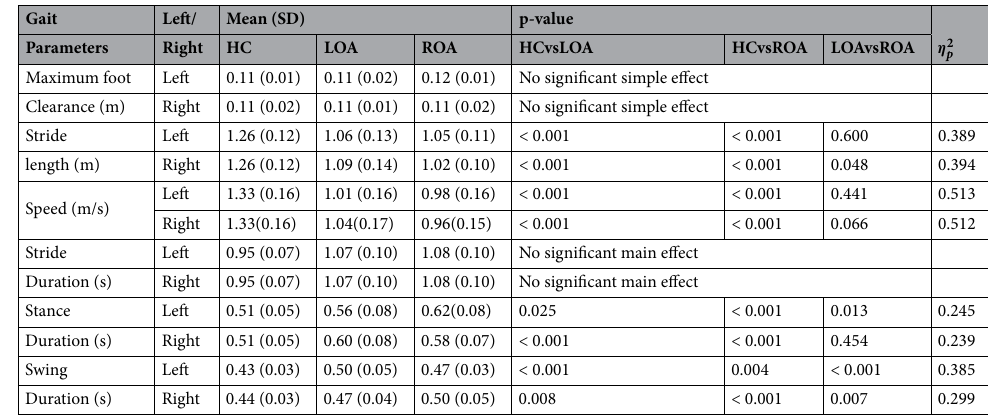
Table 2. The result of multiple comparison tests for the group. For the gait parameters other than the maximum foot clearance and the stride duration, the significant interactions and simple effect of group were found. Thus, the multiple comparison was conducted for the groups for the left and right legs separately. In the maximum foot clearance, a significant interaction was found but the simple effect was no significant. Thus, the result of the multiple comparison for the main effect is shown. Means and (standard deviations) of gait parameters. Healthy control (HC), left hip osteoarthritis (LOA), right hip osteoarthritis